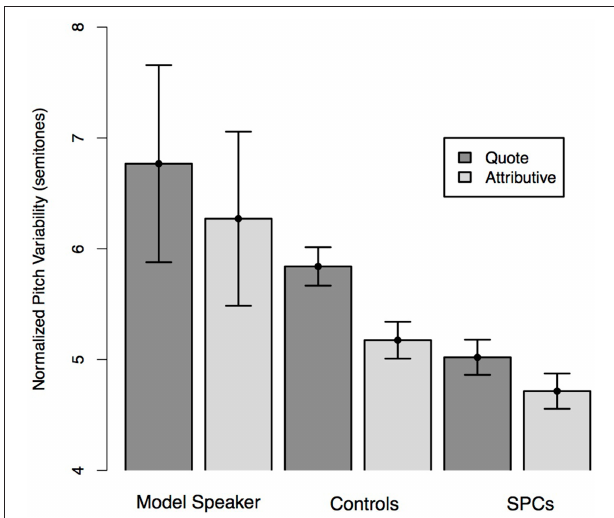
FIGURE 4 | Normalized average duration plus silence of the first conjunct of the Ambiguous Coordinate Structure sentences depending on whether the speaker intended the two-one (No Boundary) or two-two (Boundary) structure as produced by the Model Speaker, Controls, and SPCs. Error bars represent standard